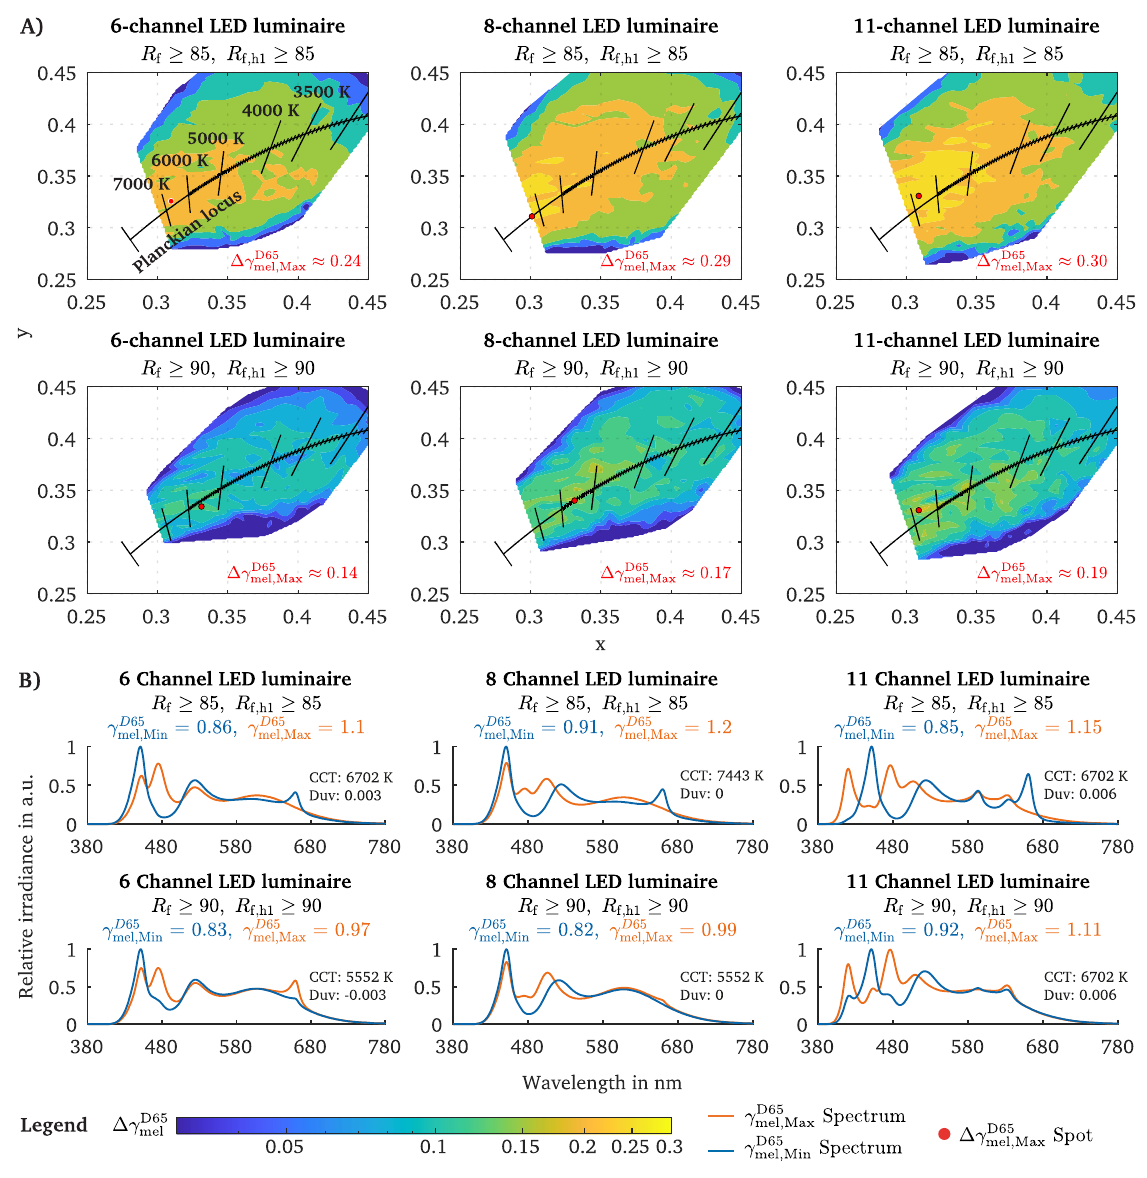
D 65 Figure 2. Melanopic metameric tuning range �γ mel across various CIExy coordinates. ( A ) The melanopic D 65 tuning range �γ mel in the CIExy-2° colour space for three LED luminaire settings (6, 8 and 11 primaries) and two different IES colour fidelity R f conditions with ( R f ≥ 85 , R f,h1 ≥ 85 ) and ( R f ≥ 90 , R f,h1 ≥ 90 ) . The red dots signal the CIExy coordinates at which the melanopic tuning range is maximal across all CCT and Duv steps D 65 D 65 ( �γ mel , Max ). The respective value of the largest melanopic tuning range �γ mel , Max is reported in the lower left D 65 of each metameric map plot. ( B ) The maximum tuning range �γ mel , Max (red dot, panel A ) is derived from D 65 D 65 subtracting the γ mel , Max and γ mel , Min values of the spectral pair that corresponds to the red dot. The two spectra D 65 of the metameric pair, which maximise the melanopic tuning range ( �γ mel , Max ), are plotted for each luminaire setting and applied colour fidelity